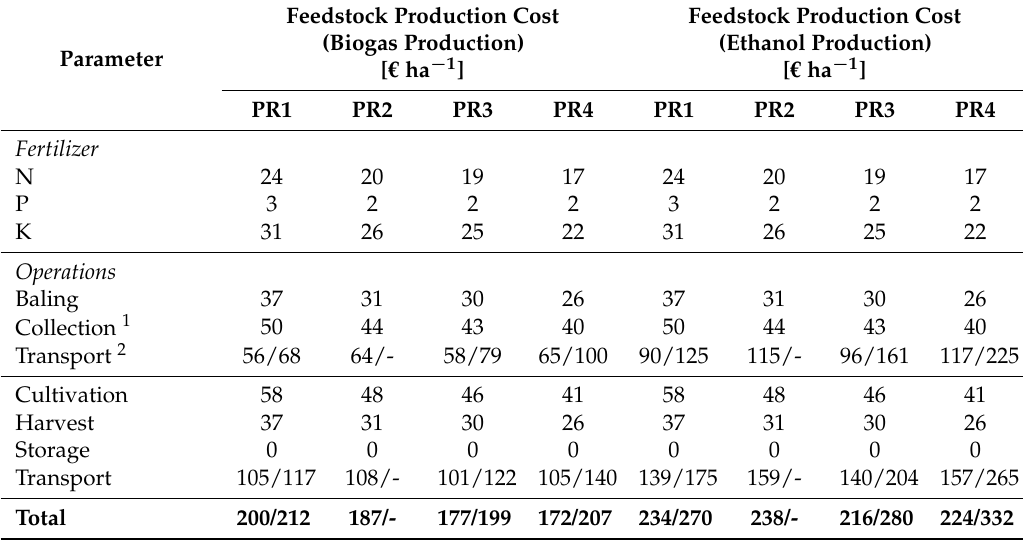
Table A8. Feedstock production costs for winter wheat straw in the different production regions (PR) for the production of biogas and ethanol, when removing amounts of straw according to fraction 3 and fractions 1–3.